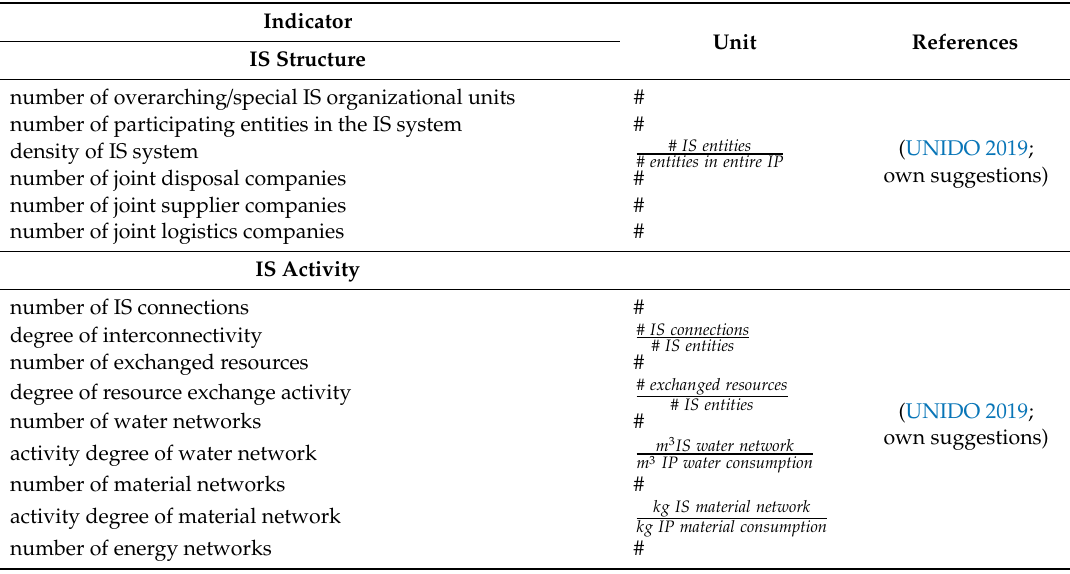
Table 2. IS general indicator